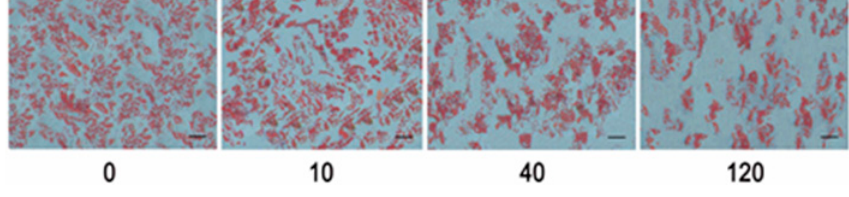
Figure 4. The inhibitory effect of muscle conditional medium (MCM) on s.c. preadipocytes differentiation. Confluenced s.c. preadipocytes were incubated in adipogenic medium supplemented with an increasing amount of MCM at the indicated total protein concentration ( n = 3). After nine days, adipocytes were staining with Oil Red O. Scale bar = 200 µ m.